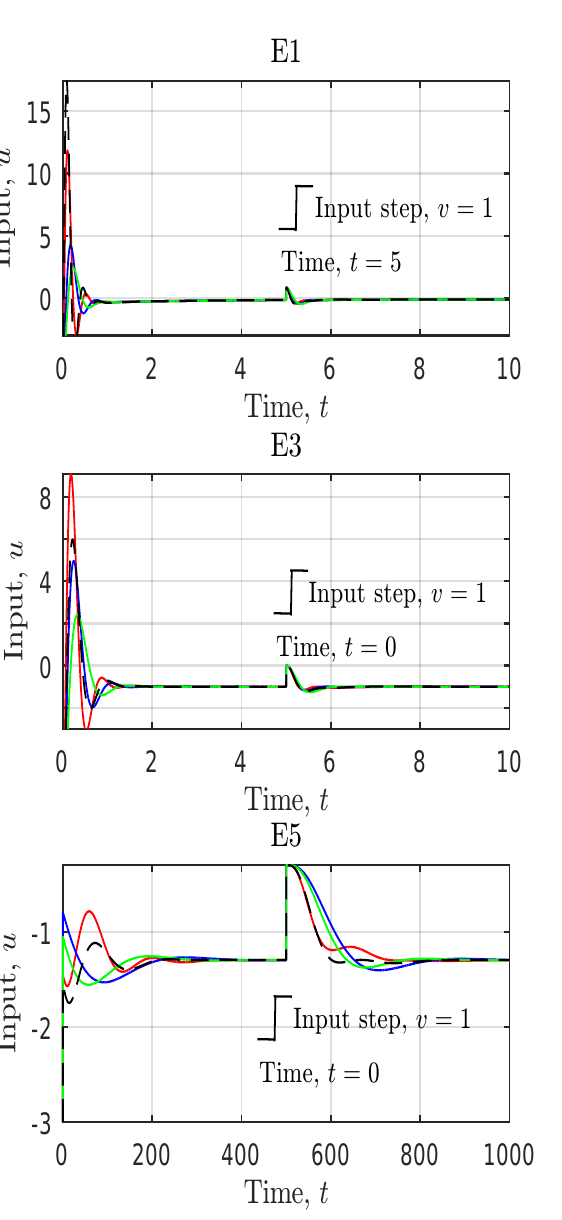
Figure 8: Es1-6. The figure illustrates the input us- age for a prescribed robustness, M s = 1 . 59, for the following methods: δ -PRC, SIMC, K- SIMC and PO